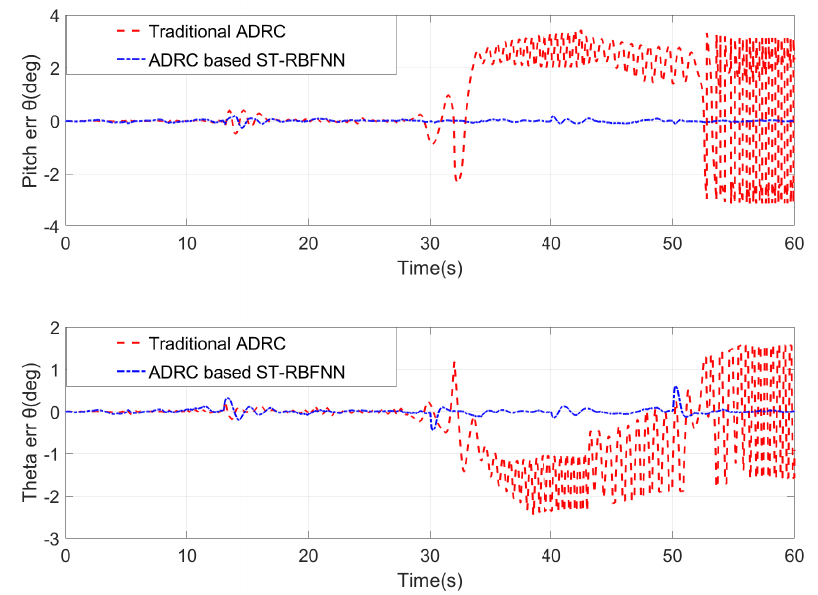
Figure 13. Flight attitude tracking error when actuator failure occurred in Scenario 3.